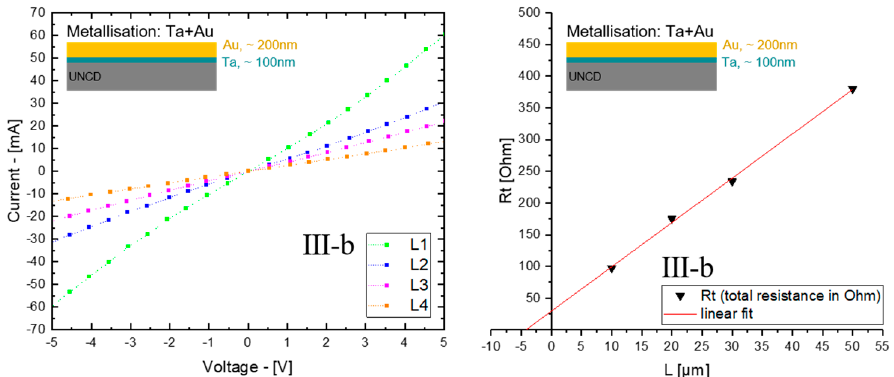
Figure 5. Ohmic I-V characteristic (left), and linear fitting of total resistance in Ohm (Rt) against LTLM pads distance L in µm (right), of subgroup sample Ⅲ -b, contact material with Ta/Au.